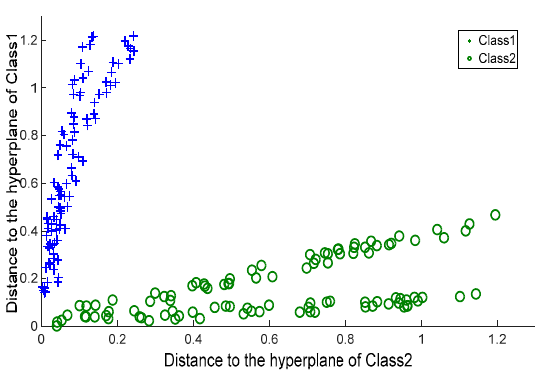
Figure 5. Multi-weight Vector projection Support Vector Machines: Distance values.